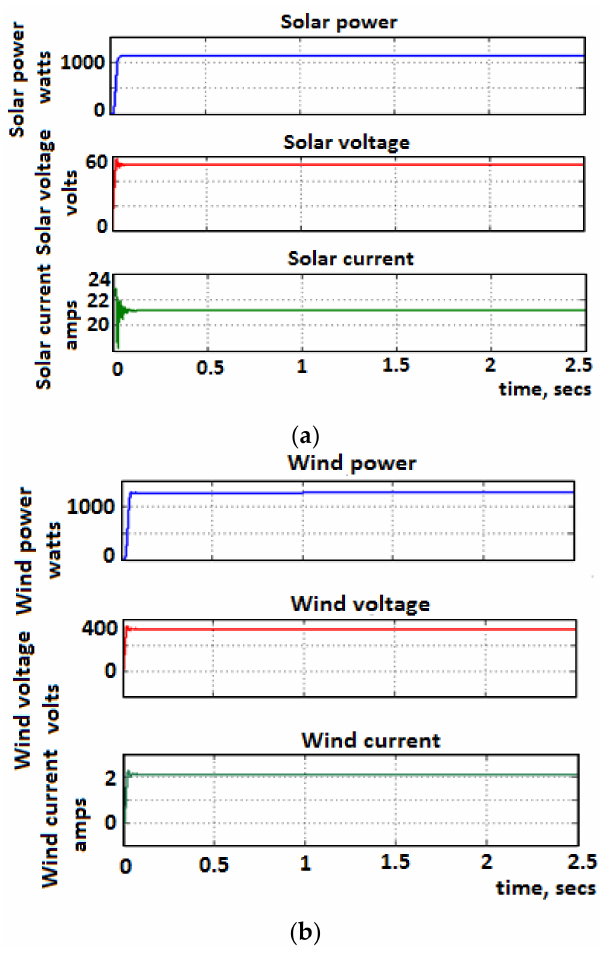
Figure 2. ( a ) Solar power, voltage and current. ( b ) Wind power, voltage and